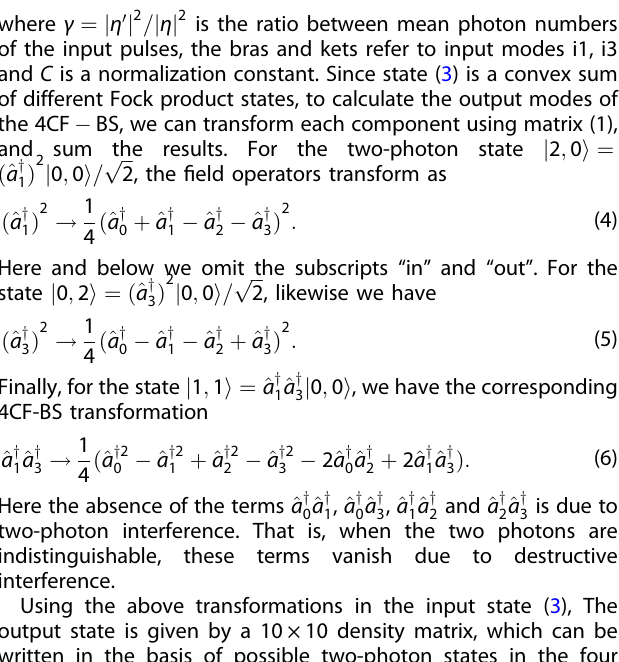
Fig. 3 Experimental results showing interference of mutually incoherent WCSs at a 4CF beam splitter. a Single count probabilities remain unchanged under variation of polarization states. b Coincidence count probabilities Pjk between detectors Dj and Dk showing interference of mutually incoherent WCSs at a 4CF beam splitter. Constructive and destructive fourth-order interfer- ence can be observed in the coincidence probabilities between pairs of detectors as a function of the orthogonality of the polarization states, while the single count probabilities (top) remain unchanged. Error bars (smaller than symbols) correspond to Poissonian count statistics. The solid gray curves represent gaussian curve fi ts to experimental data, and are intended merely as a guide for the